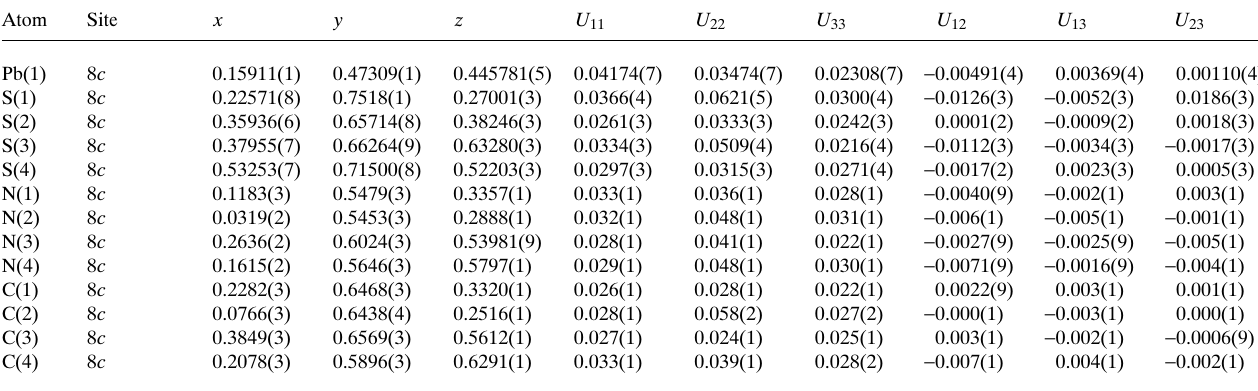
Table 3. Atomic coordinates and displacement parameters (in Å 2 )